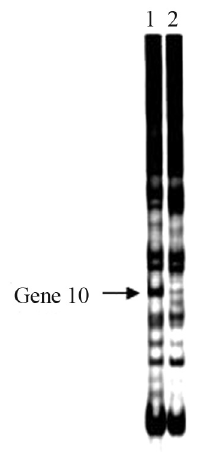
Figure 1 - Differential expression analysis of the porcine Gene 10 in longissimus muscle. The arrow indicates the cDNA profile for Gene 10 on an 8% polyacrilamide gel stained with silver nitrate. 1 - Large White; 2 -